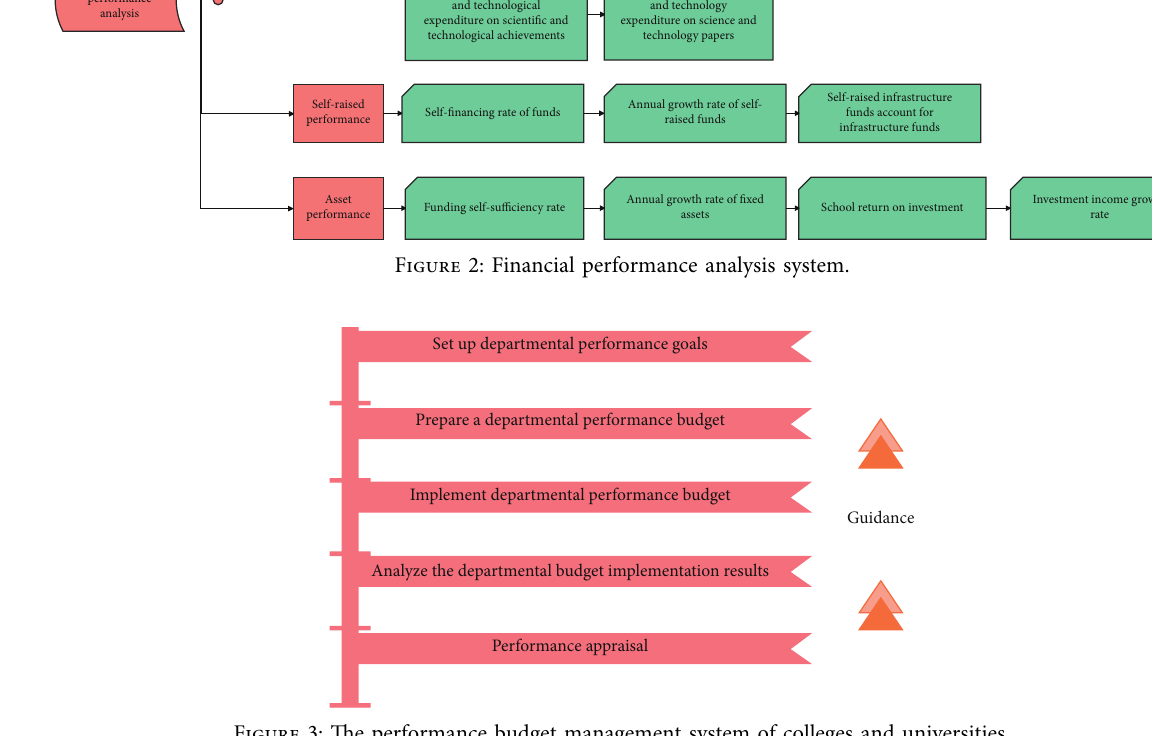
Figure 3: The performance budget management system of colleges and universities.